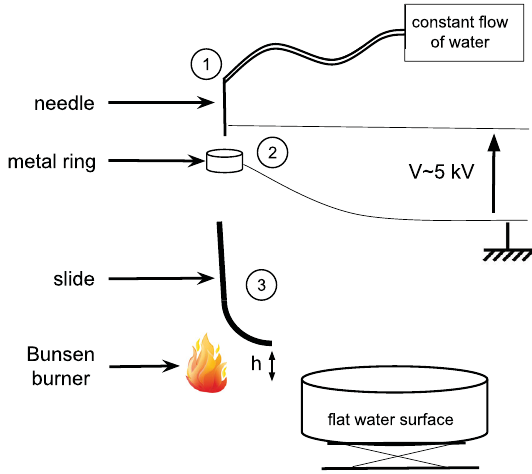
Fig. 2. Diagram of the experimental setup. The numbers (1, 2, 3) correspond to the different parts of the setup. Part 1 generates drops, part 2 triggers the mean radius of drops and accelerates them. Part 3 allows to select the impact angle of the